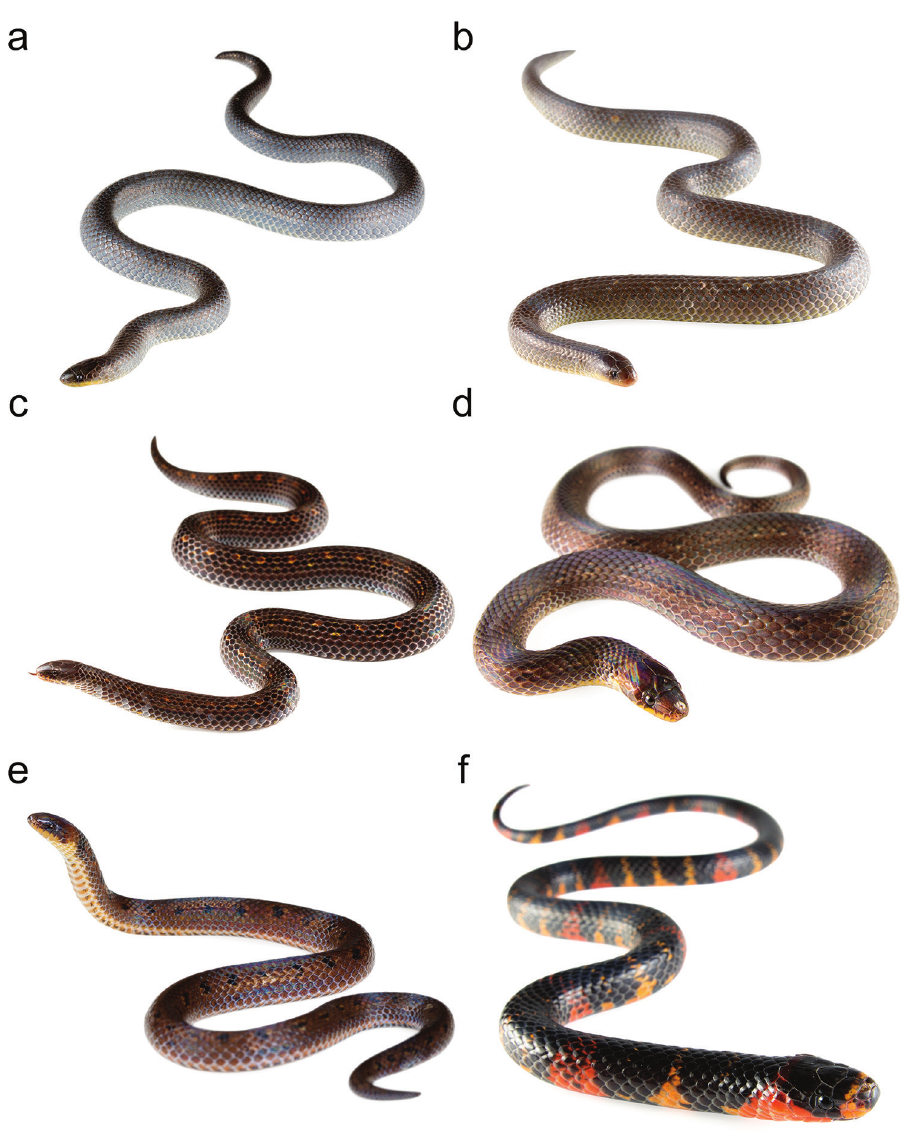
Figure 2. Photographs of some Ecuadorian species of Atractus in life: A. carrioni MZUTI 4194 ( a ), MZUTI 4195 ( b ), A. duboisi MZUTI 3640 ( c ), A. dunni MZUTI 4318 ( d ), A. dunni MZUTI 2189 ( e ), A. elaps AMARU SN ( f ), A. gigas MZUTI 3286 ( g ), A. iridescens MZUTI 3680 ( h ), A. iridescens QCAZ 8072 ( i ), A. iridescens MZUTI 4697 ( j ), A. iridescens MZUTI 3548 ( k ), A. major MZUTI 4973 ( l ), A. microrhynchus MZUTI 5109 ( m ), A. modestus ( n ), A. multicinctus MZUTI 5106 ( o ), A. occidenta- lis MZUTI 1385 ( p ), A. occidentalis MZUTI 3323 ( q ), A. paucidens MZUTI 5102 ( r ), A. resplendens MZUTI 3996 ( s ), A. roulei MZUTI 4503 ( t ), A. savagei MZUTI 4916 ( u ), A. snethlageae ( v ), A. touzeti ANF 2390 ( w ), and A. typhon MZUTI